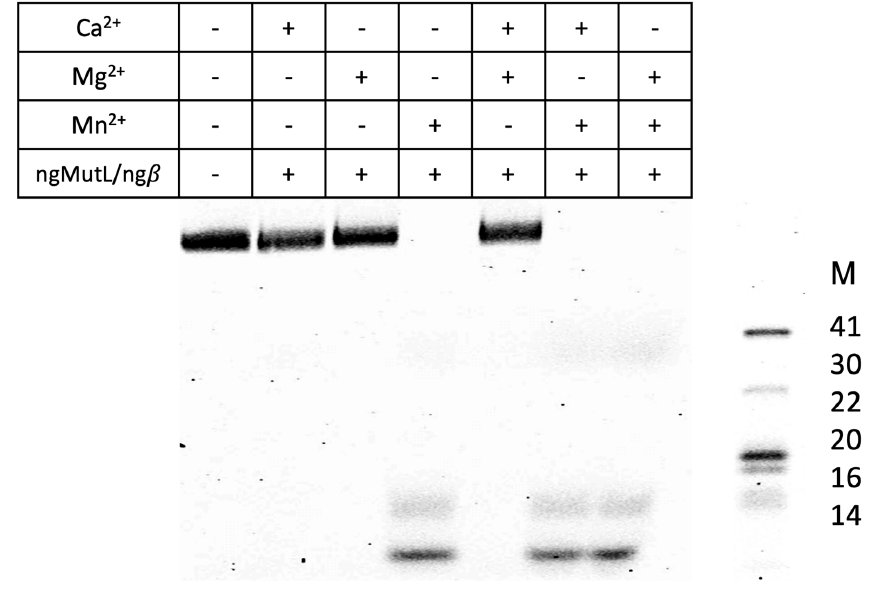
Figure 8. Effect of metal ions Mg 2+ , Mn 2+ , Ca 2+ and its combinations on ngMutL-induced hydrolysis of 76R/76M (10 nM). The reaction mixtures were incubated in the presence of 0.8 mM ATP, 5 mM metal ions for 90 min at 37 °C, and then analyzed in a 12% polyacrylamide gel containing 7 M urea; 0.5 µM ngMutL (per dimer) was used in the presence of an equimolar amount of ng β dimer. The lengths of DNA markers, M (in nucleotide residues), are shown.